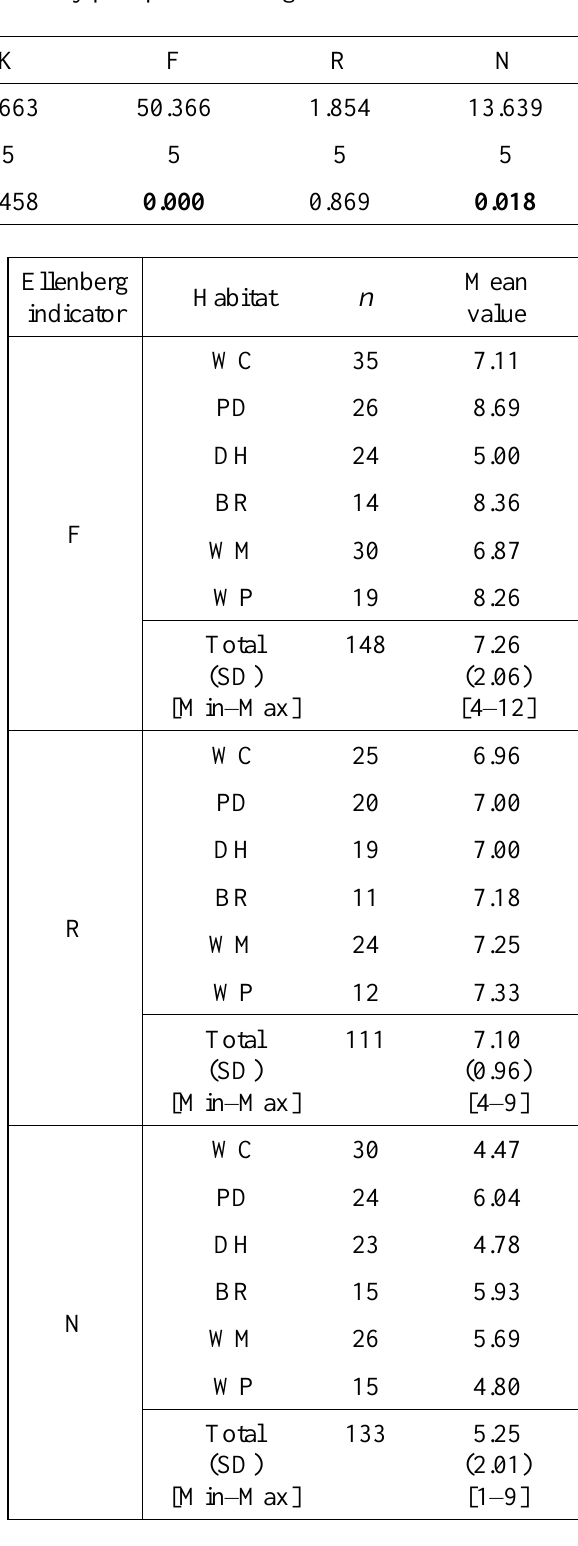
Table 1. Kruskal-Wallis test of habitat differentiation for the plant taxa in Chaman-e Kelar Mire based on Ellenberg’s indicator values. Significant results ( p < 0.05) are indicated by bold type. Descriptive statistics shown separately for each Ellenberg indicator are: mean, standard deviation (SD), minimum (Min), maximum (Max) and number ( n ) of observations (plant species). Ellenberg indicators: L = light; T = temperature; K = continentality; F = moisture; R = soil reaction; N = nutrients. Habitat types: WC = patches of Carex orbicularis on wet peat hummocks; PD = peaty depressions with stagnant surface water; BR = brooklets; DH = dry hummocks; WM = wet meadows; WP = loose watery peat patches along